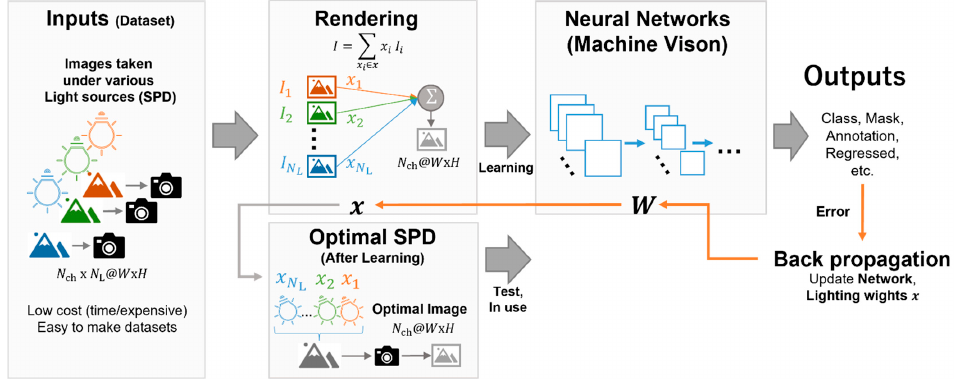
Figure 2. The concept of optimization of the light-source spectra using a neural network (NN). The input to the model is a set of images of objects taken with the same camera under sub-spectral power distributions (SPDs) that have different spectral proportions from each other, where each sample is composed of 𝑁 (cid:2896) number of sub-light images of 𝑁 (cid:2913)(cid:2918) -channels. The input image is linearly combined according to the lighting weights x to obtain a single image with 𝑁 (cid:2913)(cid:2918) -channels (rendering process), fed into the NN model. During training, the NN model’s weights 𝑾 and 𝒙 are updated simultane- ously according to the gradients, which are computed by backpropagation from the cost (error) of the NN model’s output. After sufficient training, the accumulated SPD obtained by mixing the sub- SPDs with intensities of 𝒙 becomes the optimal light source for the machine learning problem. The image measured under the optimal light source is equivalent to the image obtained by the rendering process. This can be entered into the model for inference with fewer shots of images than when the dataset was obtained. The features under the optimal light source composed of the sub-light sources can be computed using a weighted sum of the lighting weights of the features under these sources (Figure 1). As the output to the subsequent layer is the sum of the product of the lighting weights, 𝒙 , and the input, it is differential by 𝒙 . Suppose the light-source optimi- zation is applied to the neural network model that is end-to-end; in this case, every layer’s outputs in the model are differentiable by the weights, thereby rendering it an end-to-end learning model. A neural network with a fully connected layer, convolutional layer, and fully connected layer (FCL) was applied to the model to validate the proposed optimiza- tion method (Figure 3).